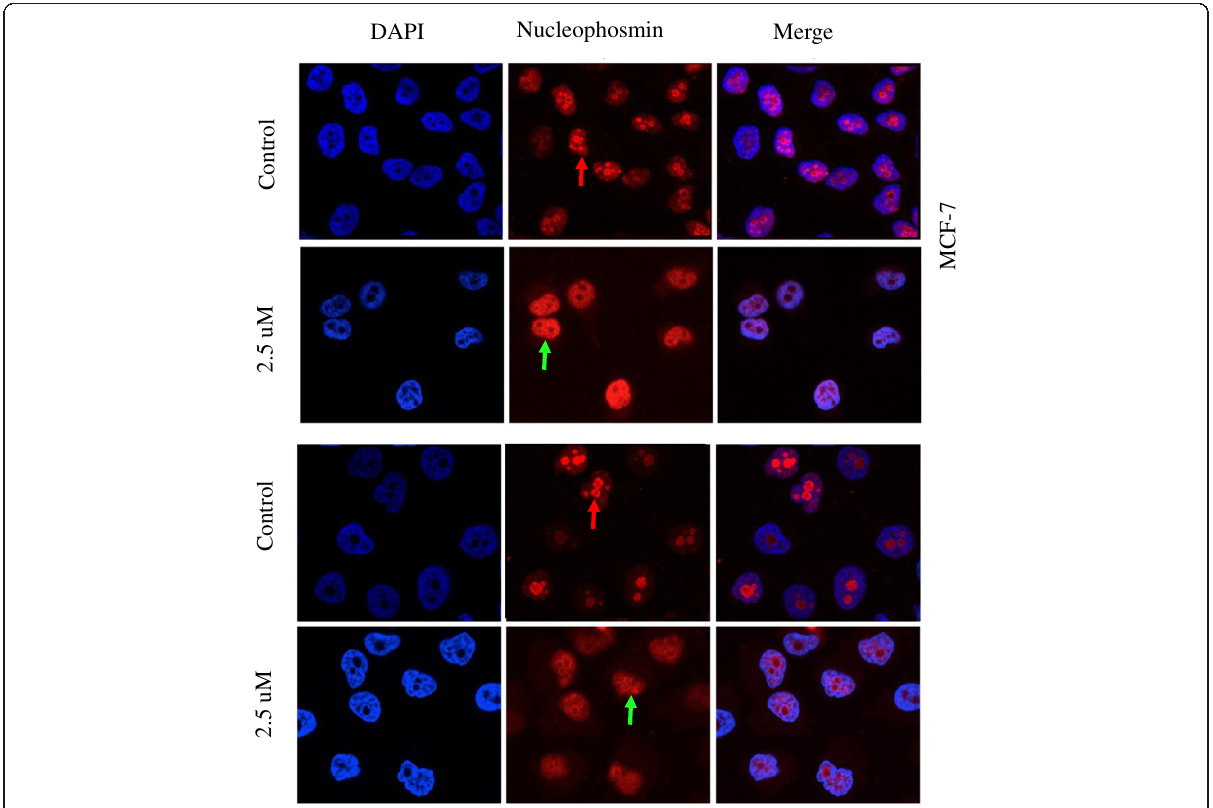
Figure 6 Cucurbitacin B changes nucleophosmin/B23 localization in human breast cancer cells. MCF-7 and MDA-MB-231 cells were stained with anti-nucleophosmin/B23 primary antibody. Alexa 568-conjugated anti-mouse IgG rabbit antibody was used as secondary antibody. DAPI was used for nuclear localization. Stained cells were analyzed by using confocal microscope. After exposure to 2.5 μ M cucurbitacin B for 20 min. Translocation of nucleophosmin/B23 from nucleolus (red) to nucleoplasm (green) was